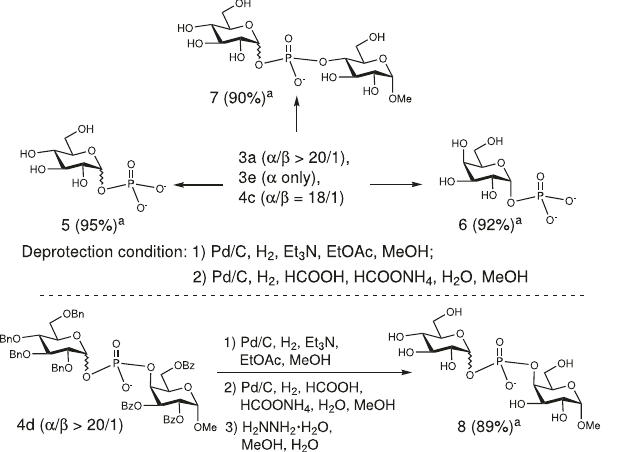
Fig. 6 Global deprotection of armed glycosyl phosphoesters. a Yields of isolated products. Bn: benzyl. Bz: benzoyl.